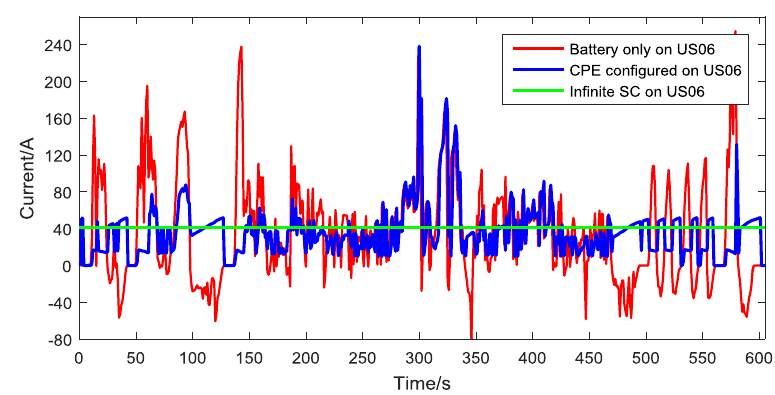
Figure 18. Battery current on US06.